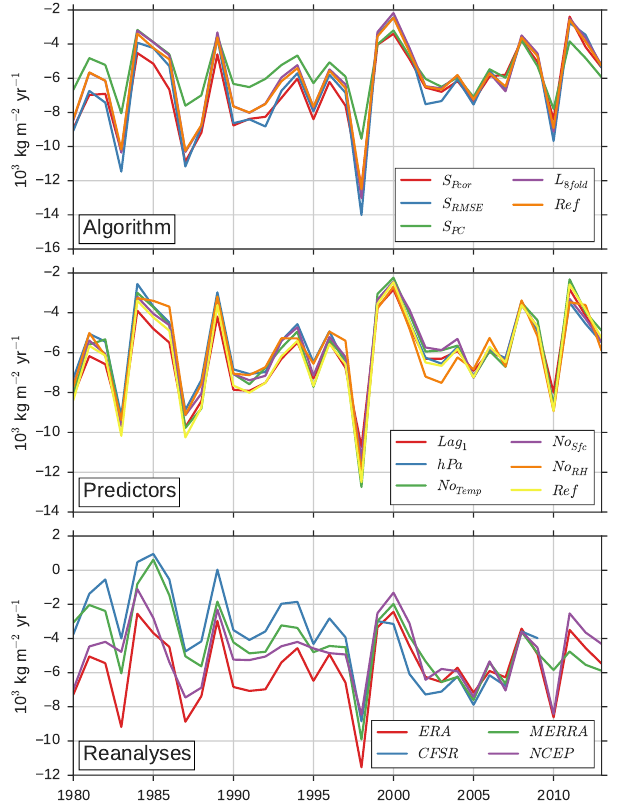
Figure 12. Computed annual MB 4750 for each category of the sen- sitivity experiments (see Table 3 for the description of the exper- iments). The period 2005–2009 is the calibration period and thus with the smallest spread.